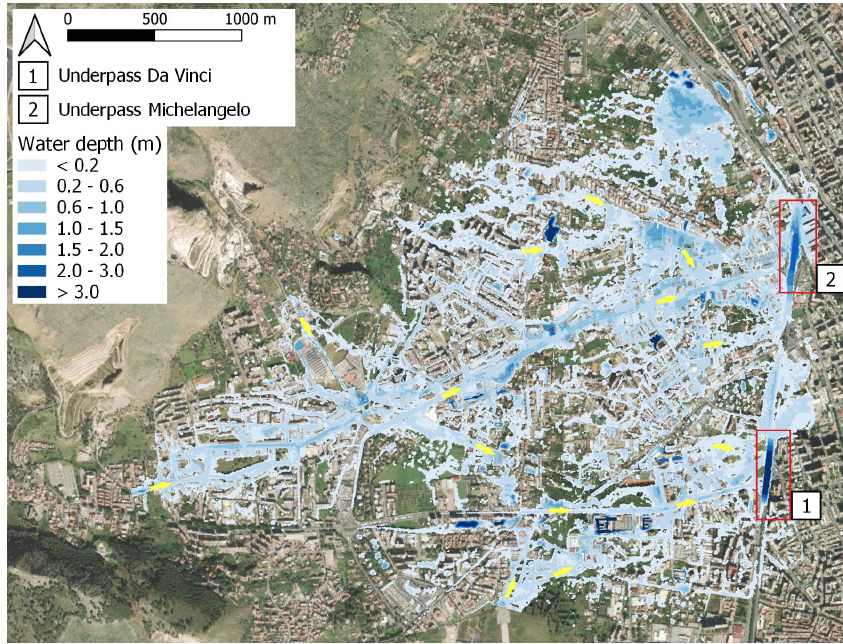
Figure 11. Map of the maximum flood depths reached on 15 July 2020 for the Uditore–Passo di Rigano district as simulated in WEC-FLOOD. The yellow arrows indicate the flow directions of the flood. Source: © Google Maps Satellite basemap available within the QuickMapServices plugin of Quantum